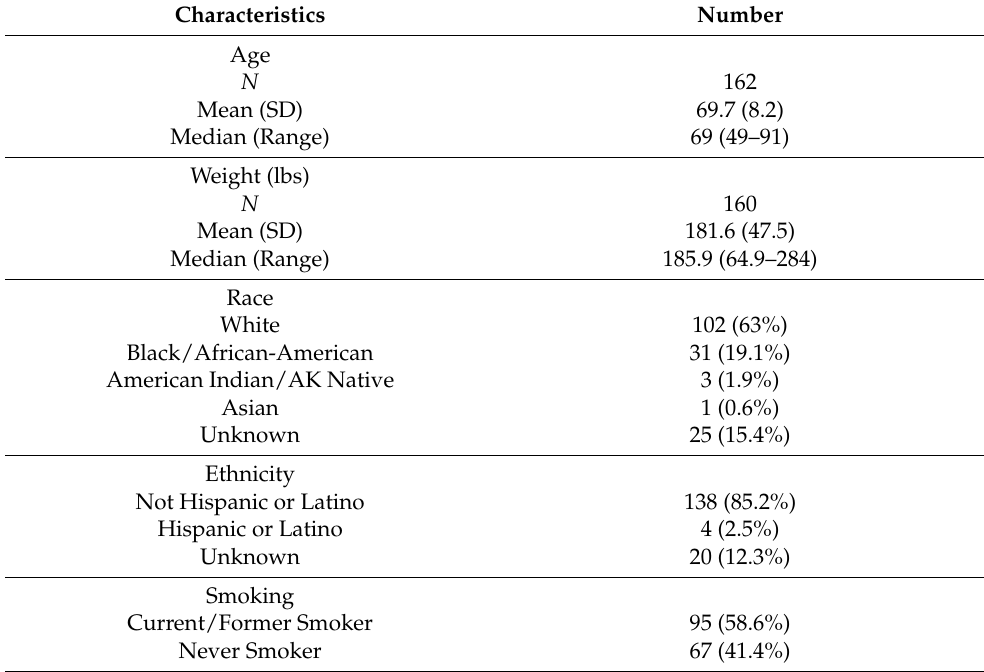
Table 1. Patient